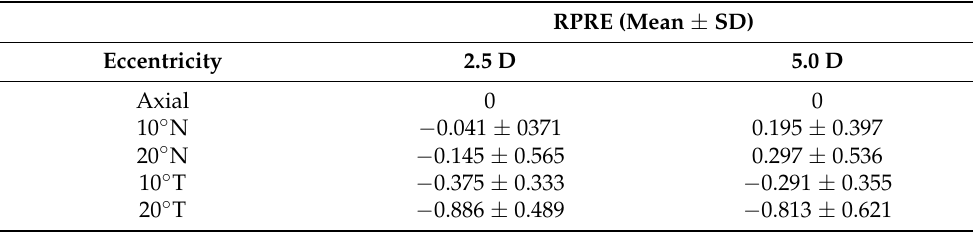
Table 7. RPRE values for each eccentricity and accommodative demand (mean ±